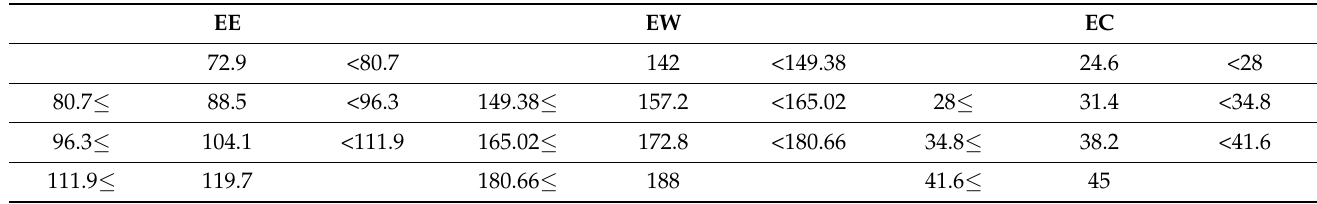
Table 4. Size of sections based on representative dimensions